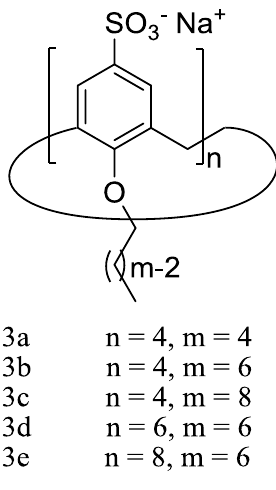
Figure 4. Amphiphilic p -sulfonatocalix[ n ]arenes used to establish structure aggregation relationships in references